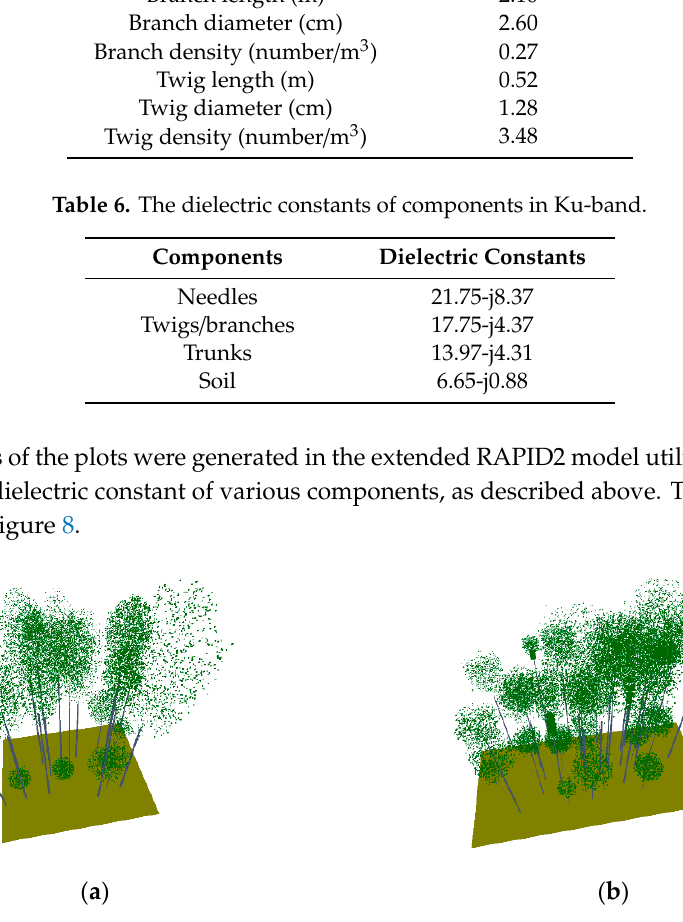
Figure 8. The virtual 3D scenes in the extended RAPID2: ( a ) 3D scene of plot 1; ( b ) 3D scene of plot 2.